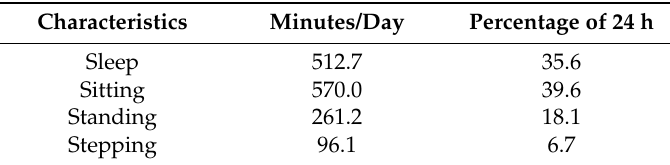
Table 2. Geometric means of physical behaviour composites.